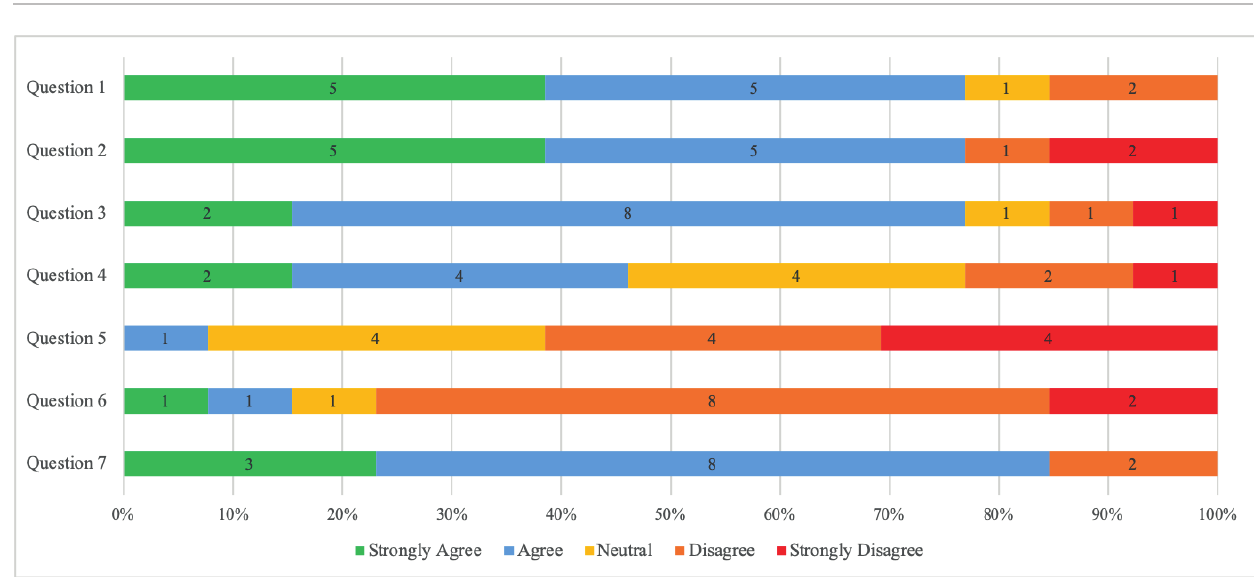
Figure 3. Post hilotherapy questionnaire